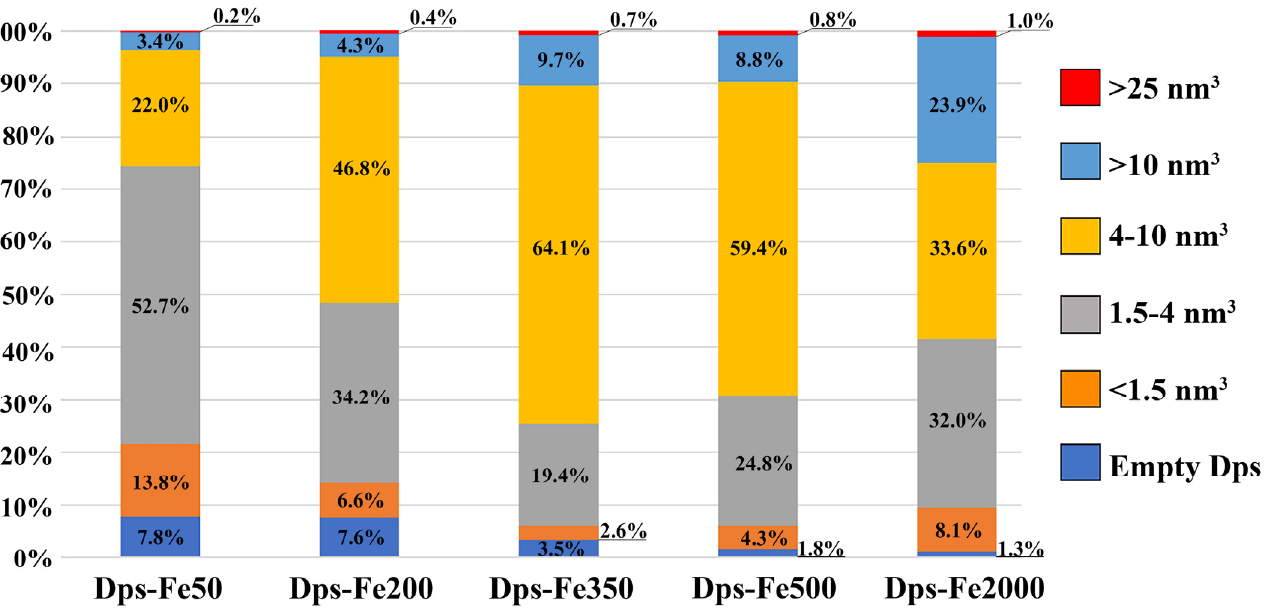
Figure 6. Histograms of the iron core volume distribution in various samples incubated for 24 h.